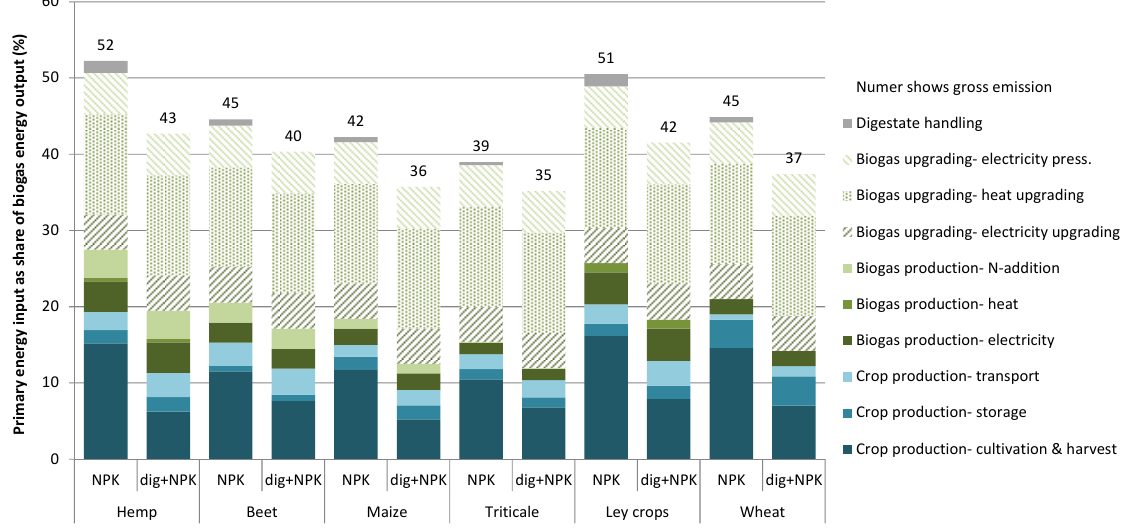
Figure 1. Primary energy input as a proportion (%) of the biogas energy output, divided between the different process steps, for the two alternative cultivation systems; including only mineral fertiliser (NPK) and digestate complemented with mineral fertiliser (dig+NPK), respectively. Based on Tables 1 and